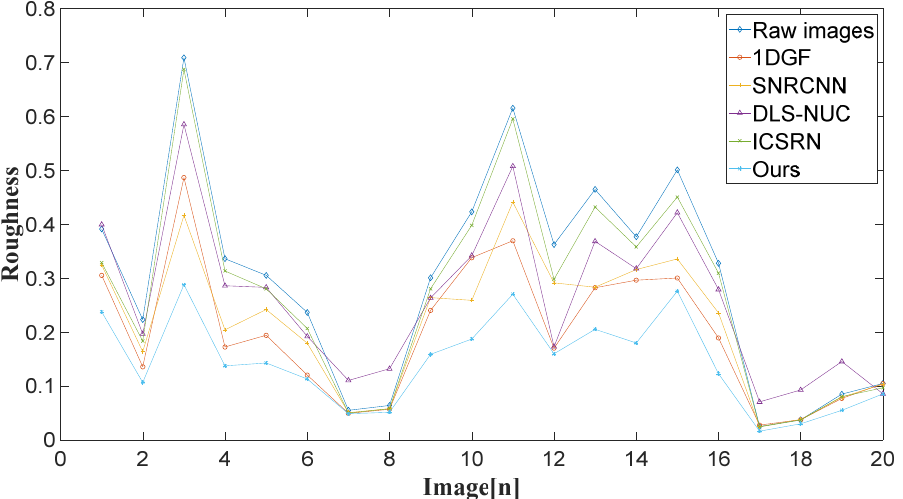
Figure 16. Roughness of different methods for 20 real noise infrared images.